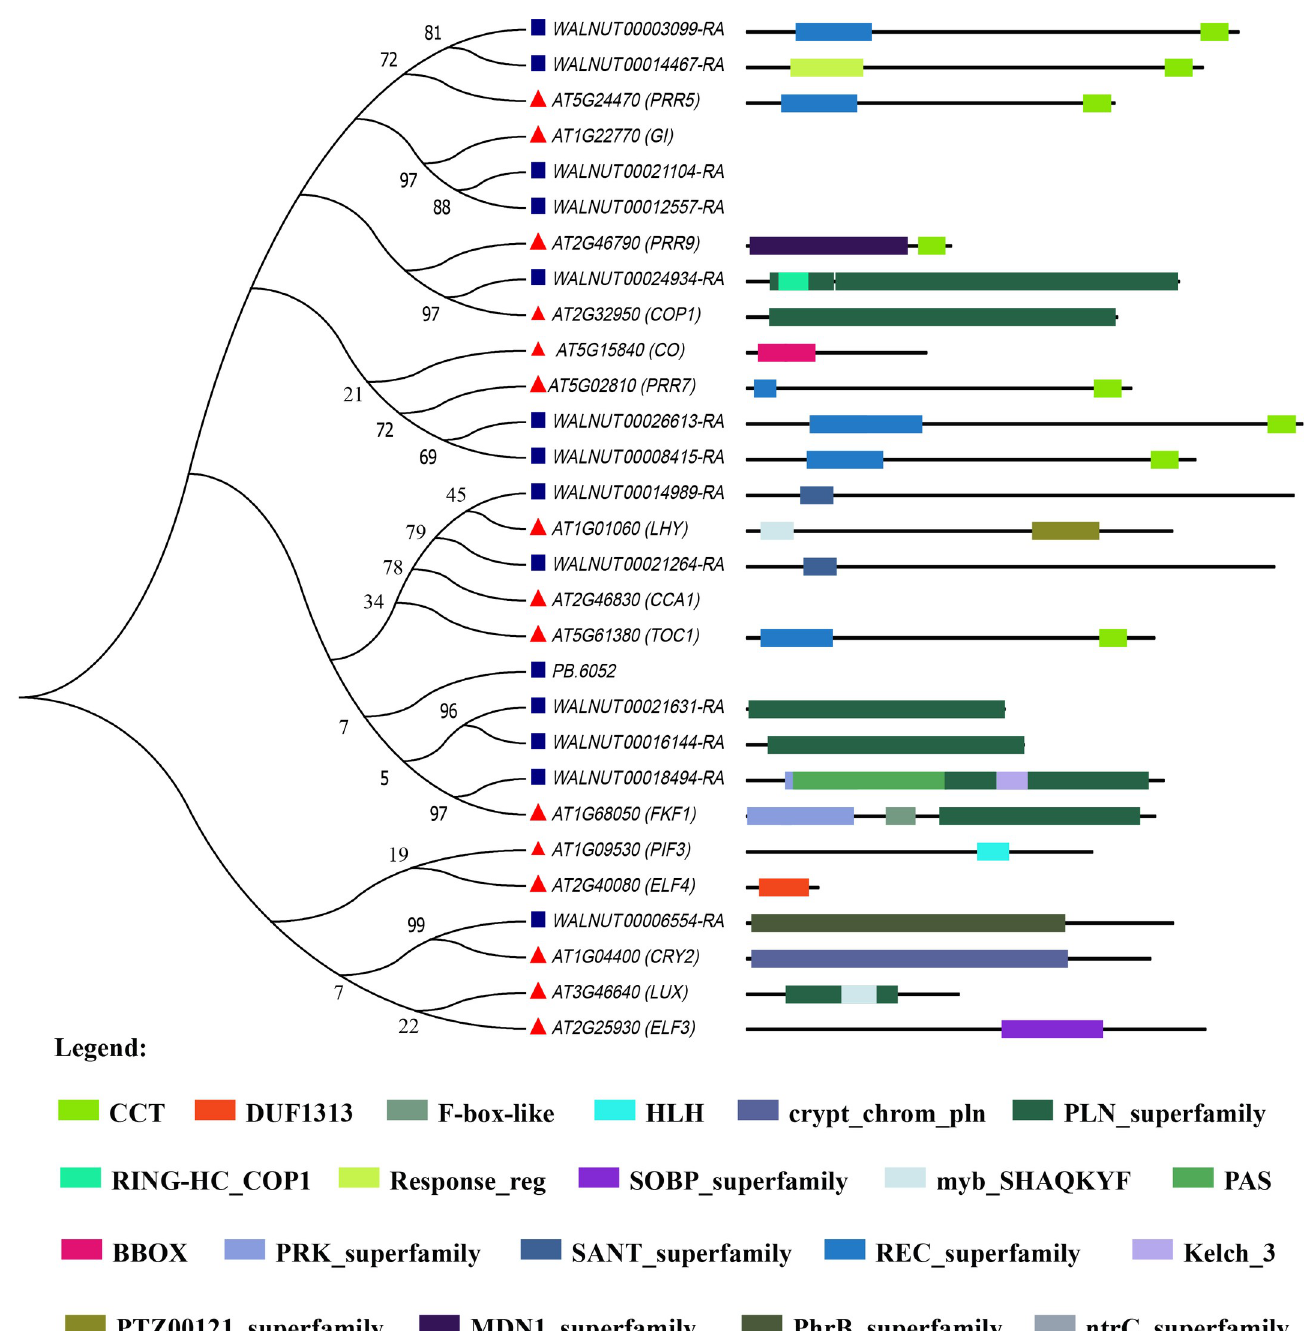
Fig 4. Phylogenetic tree and conserved structure domain of plant circadian rhythm proteins in walnut and Arabidopsis .